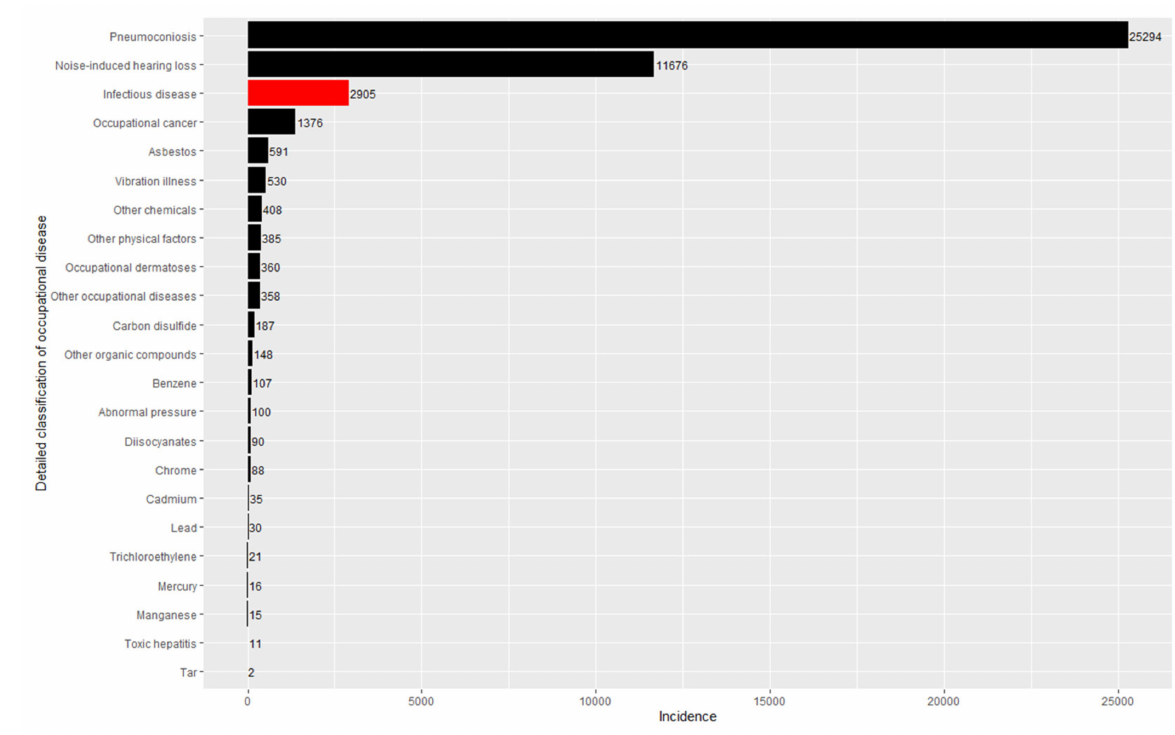
Figure 1. Incidences of occupational diseases (2001–2020).